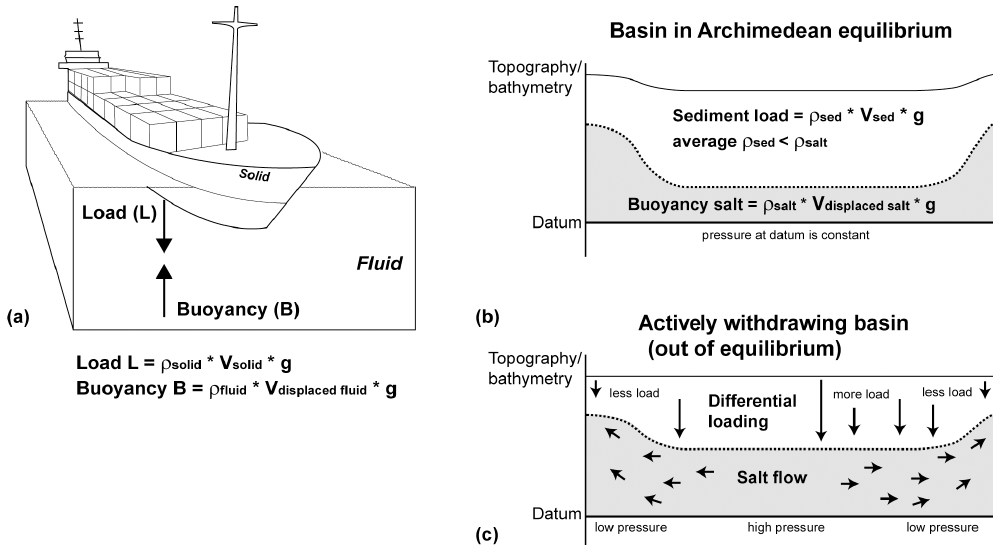
Figure 1. Archimedes’ principle. (a) Ship floating on water. Buoyancy as upward force exerted by the fluid (water) that opposes the weight of the partially immersed ship. (b) Basin above subsurface evaporites in Archimedean equilibrium. Salt treated as dense pseudo- fluid ( = 2.2gcm − 3 ) loaded by cumulatively lighter overburden rocks (solid). Backstripping corresponds to incremental unloading of the overburden (sensu Maystrenko et al., 2013). Archimedean restoration of the Zechstein Basin example justified by slow subsurface salt flow. (c) Basin out of equilibrium by major differential loading with significant salt flow and high differential pressure at datum